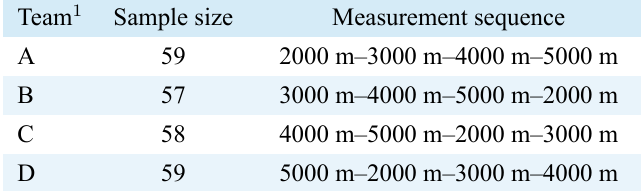
TABLE 3. Randomized measurement